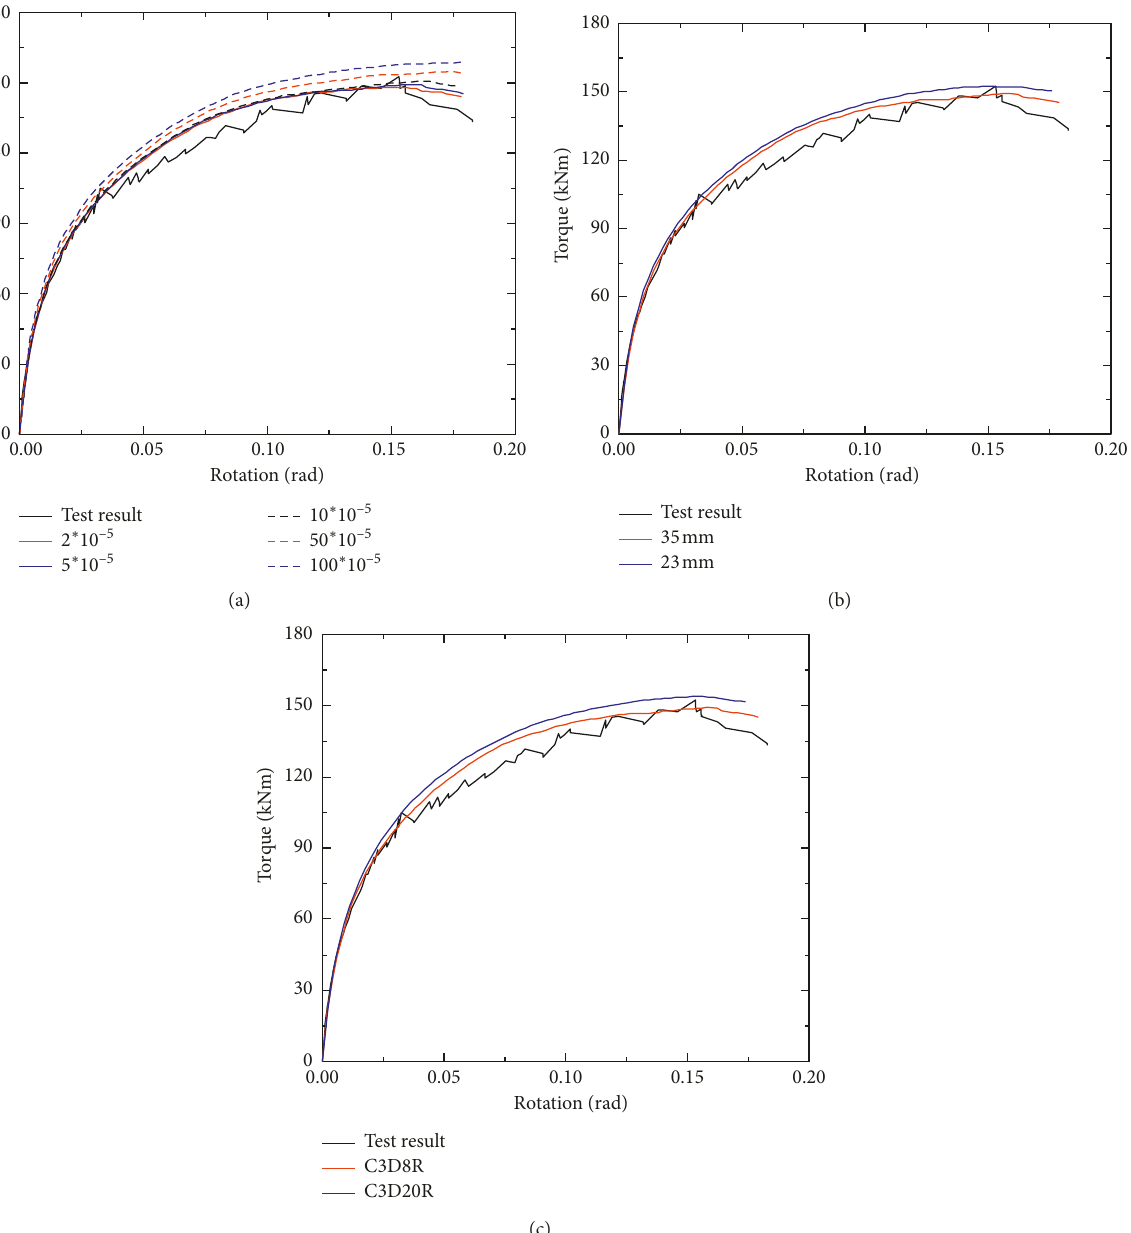
Figure 11: Torque-rotation curves with (a) different viscosity parameters, (b) different mesh sizes, and (c) different element